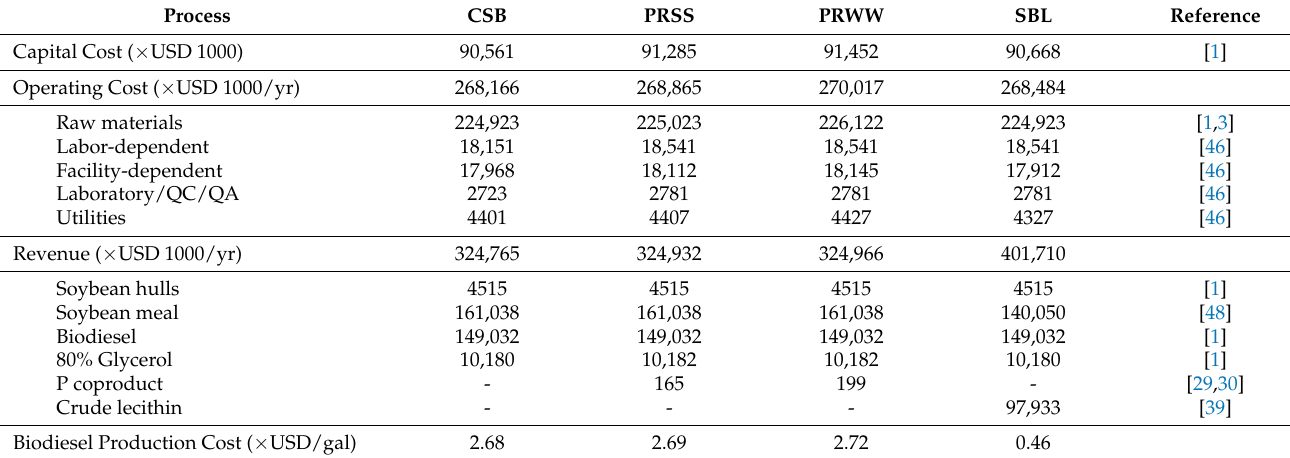
Table 2. Process economics for the four cases of soybean